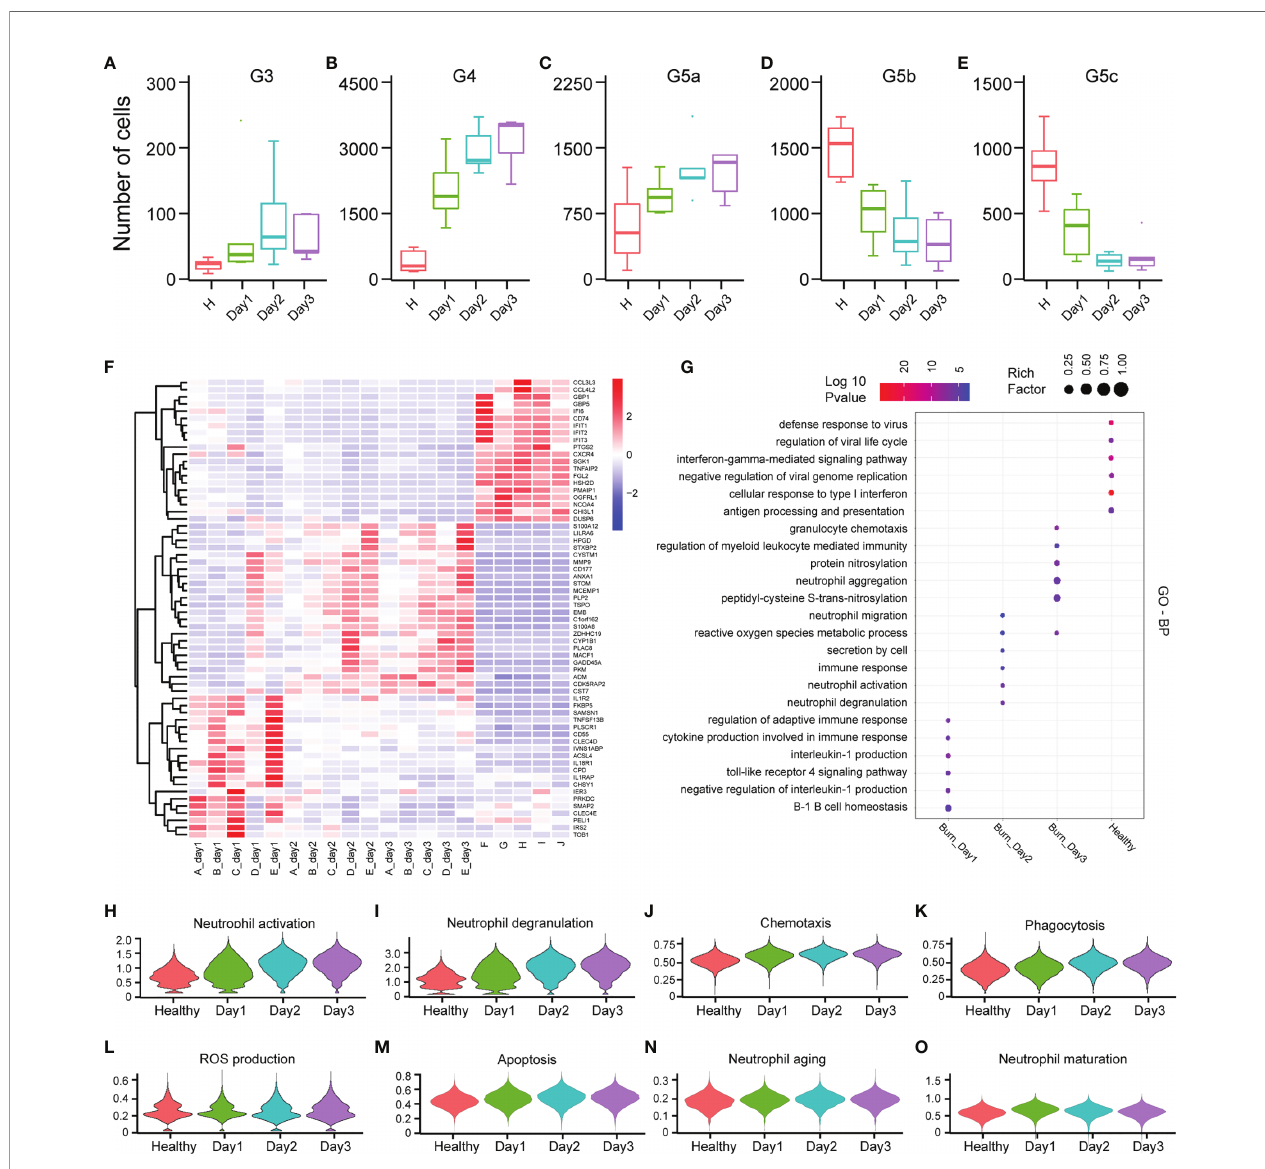
FIGURE 6 | Differences in the functional characteristics of PMNs in the fi rst 3 days of severe burn injuries. (A – E) Dynamic changes in the number of PMNs in each subgroup. (F) Heatmap of differential gene changes in 20 samples. (G) GO (BP) analysis results of PMNs in healthy controls and 3 days before severe burn injuries. (H – O) Violin plot of multiple functional changes in